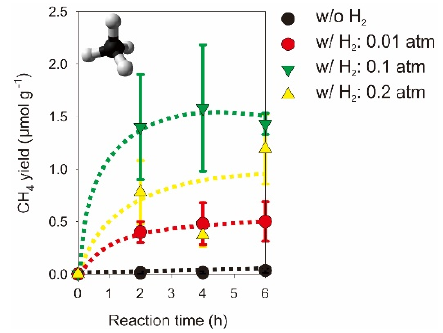
Figure 6. The time-dependent yield of CH 4 evolution over 1 wt % Pt/CuAlGaO 4 photocatalyst under different H 2(g) partial pressures in a gas phase reactor. Lines are not based on a kinetic model and are presented for eye-guiding only.